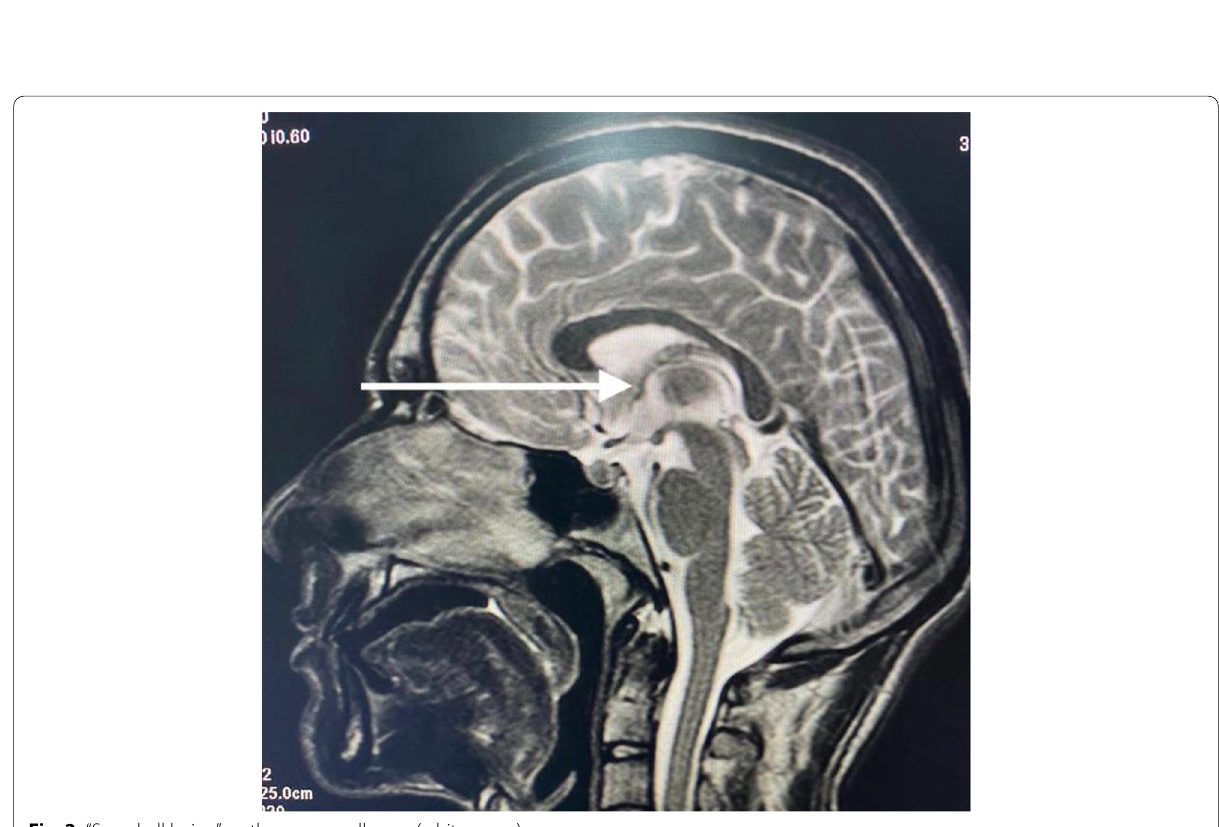
Fig. 2 “Snowball lesion” on the corpus callosum (white